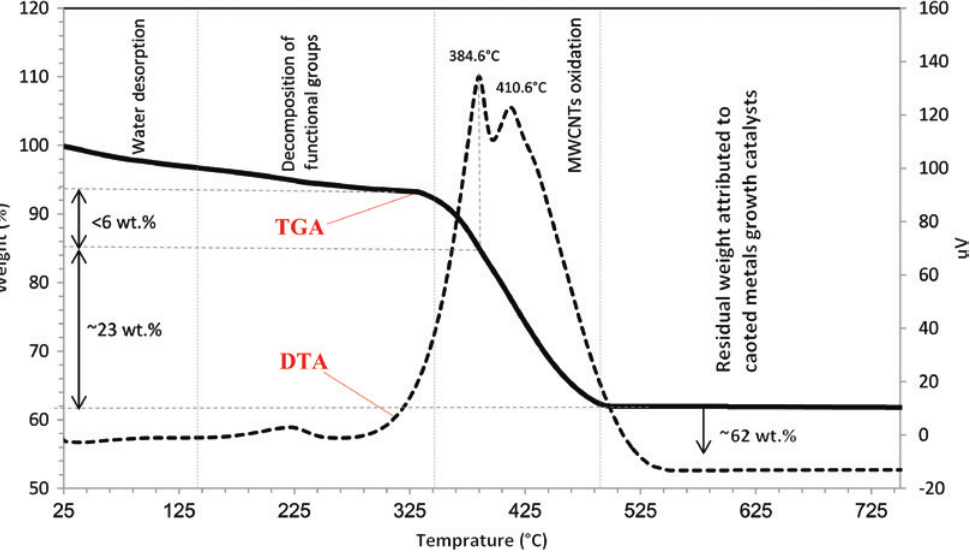
Figure 5: TGA/DTA profiles of MWCNTs coated by copper.